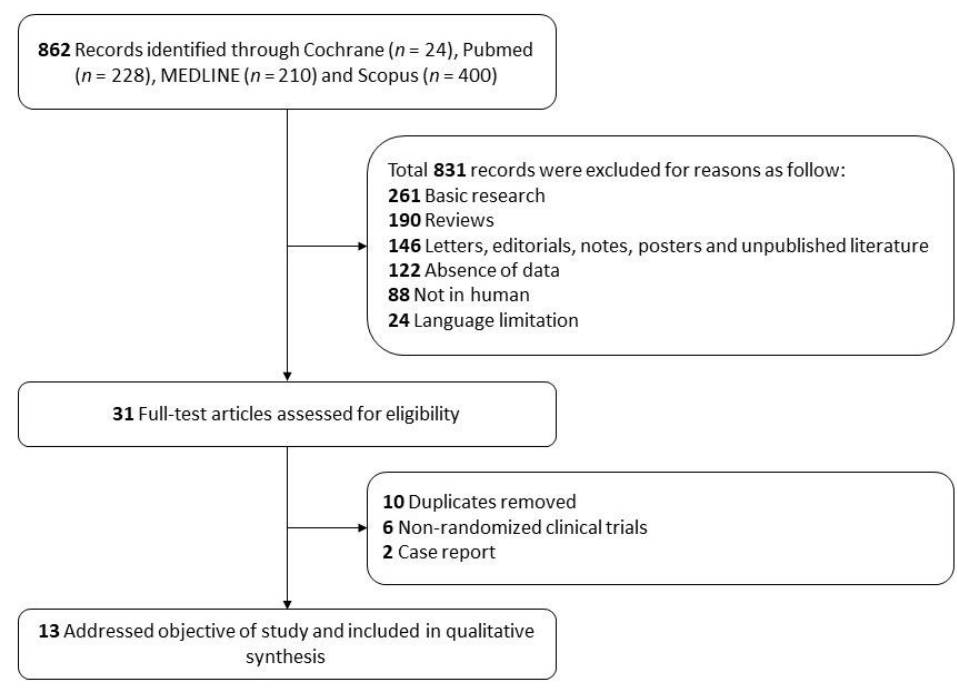
Figure 2. Flow diagram of the study selection process for inclusion in the systematic review according to the Preferred Reporting Items for Systematic Reviews and Meta-Analysis (PRISMA).